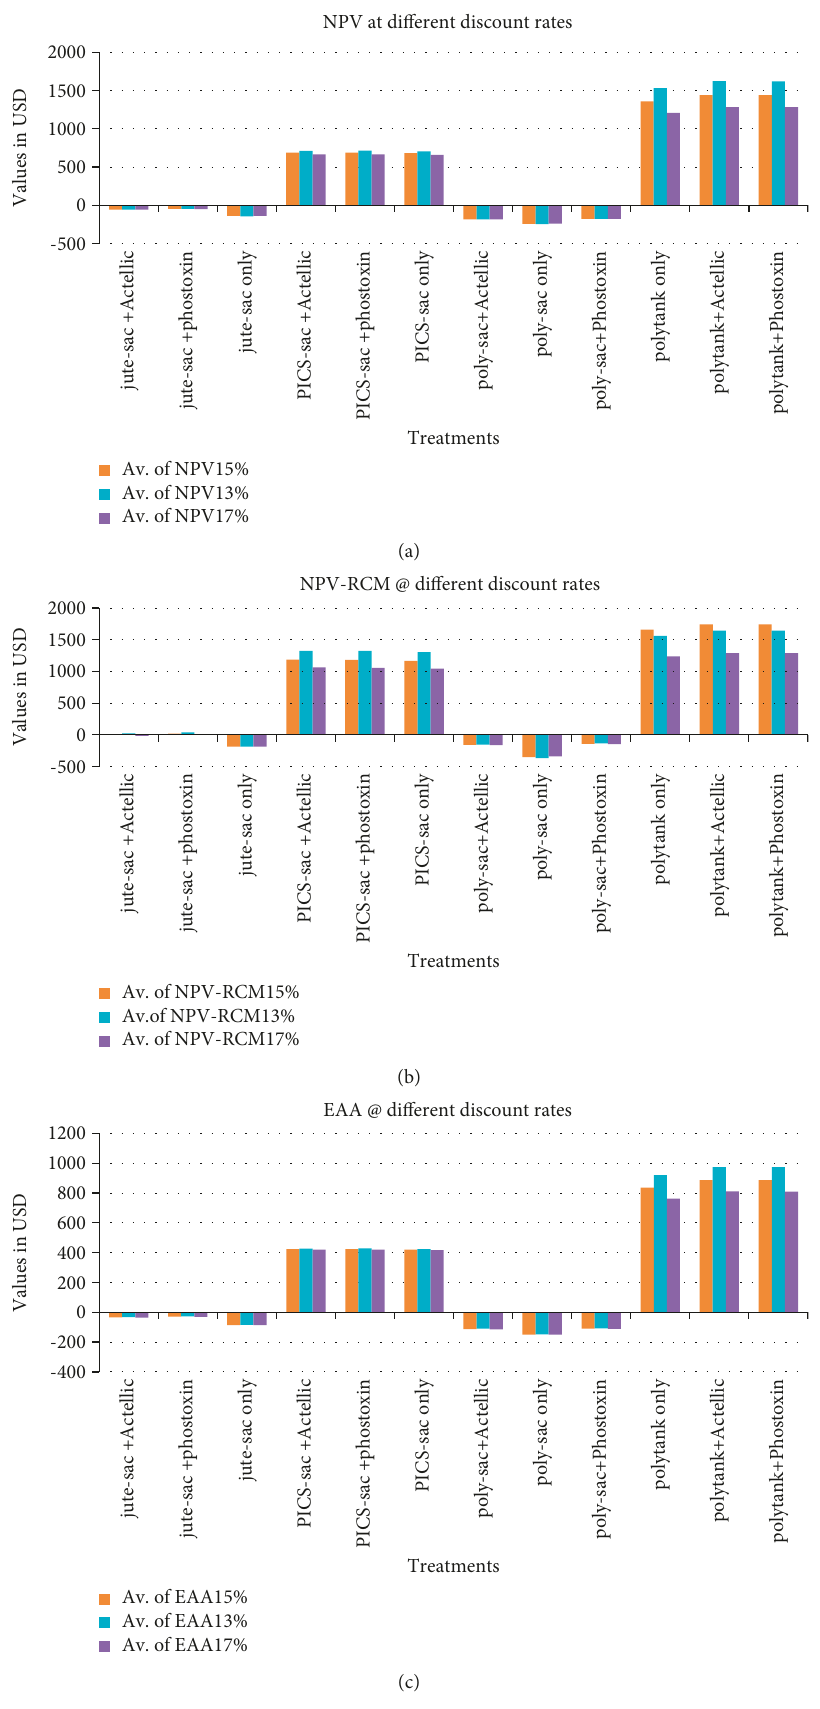
Figure 7: NPV, NPV-RCM, and EAA of cowpea storage at different discount